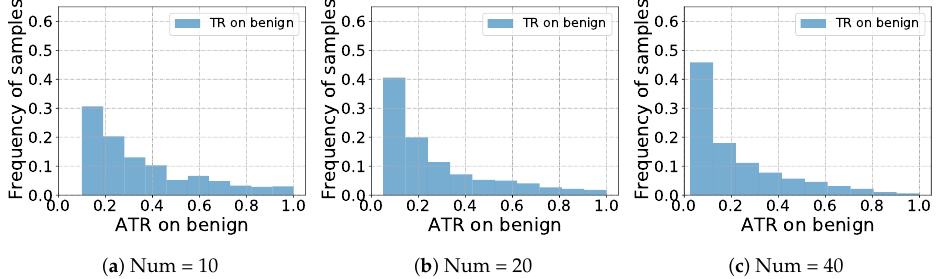
Figure 3. The probability distribution of the transfer rate of all adversarial samples generated by the adversary A . The horizontal axis is the transfer rate of a single adversarial sample, and the vertical axis is the frequency of samples at that transfer